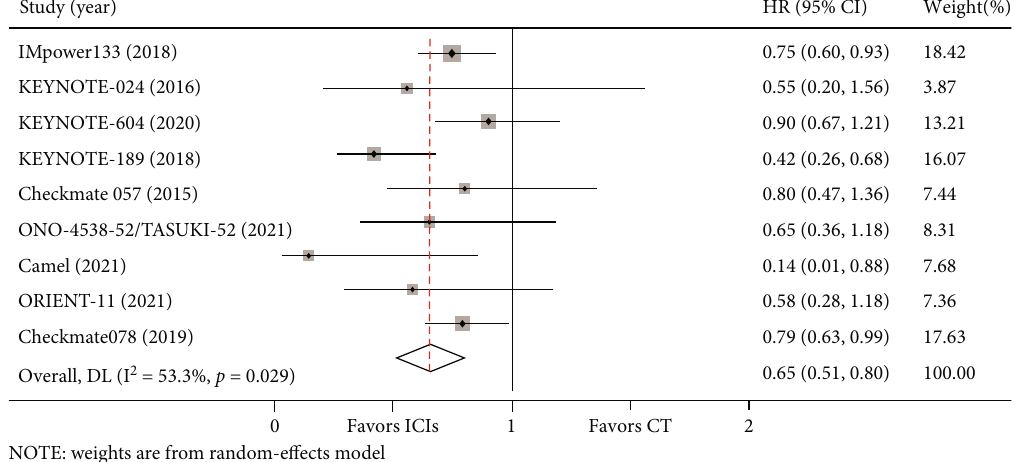
Figure 4: Forest plot of PFS between immune checkpoint inhibitors (ICIs) group and chemotherapy (CT) group for lung cancer with